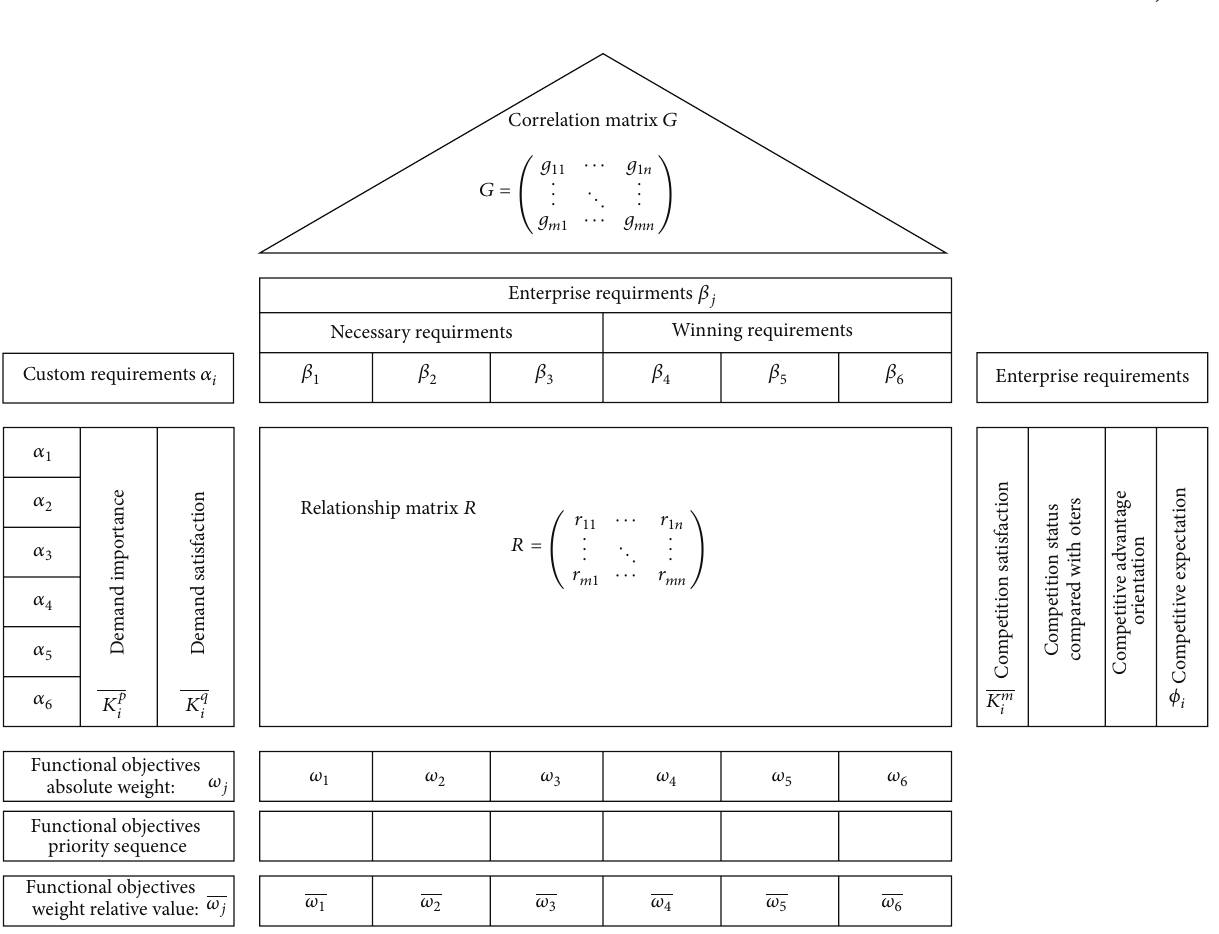
Figure 2: Quality house of module construction.